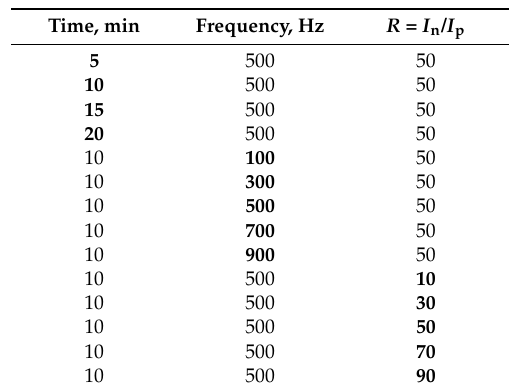
Table 2. PEO process parameters used in the second anodization campaign.